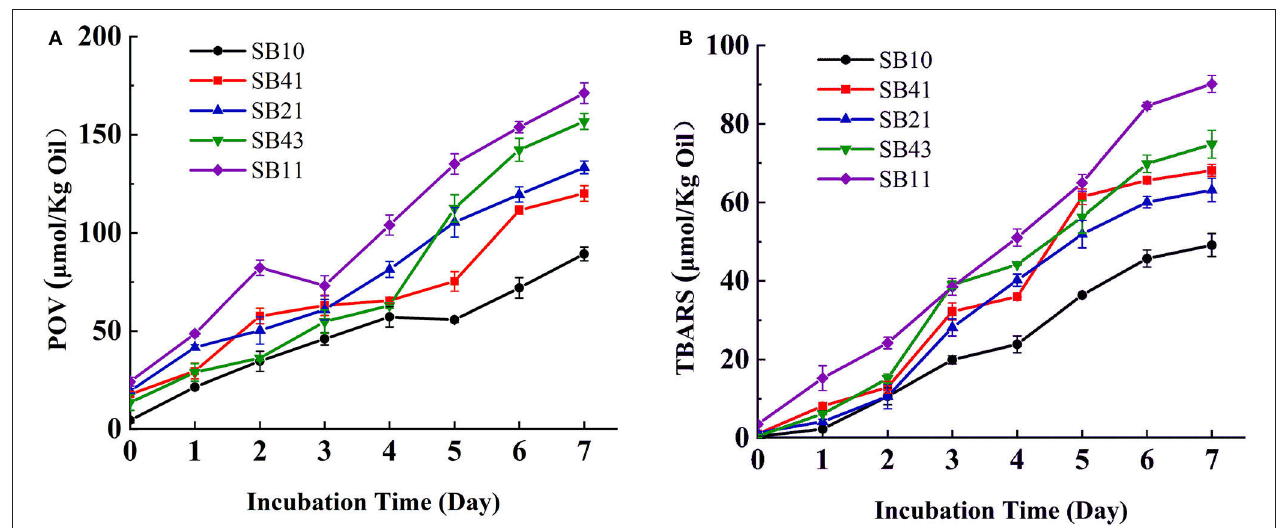
FIGURE 7 | Changes in POV (A) and TBARS (B) of the emulsions with SPI, BPC, and different SPI/BPC ratios (4:1, 2:1, 4:3, 1:1), respectively.